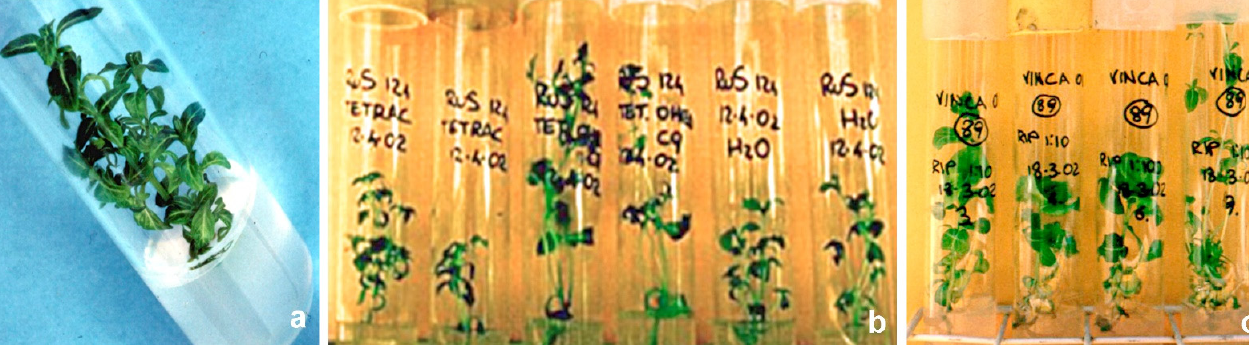
Figure 3. Periwinkle shoots in micropropagation: ( a ) untreated shoot; ( b ) phytoplasma-infected shoots treated with tetracyclines (the two central shoots were treated with 9 CH dynamized tetracycline); ( c ) shoots treated with PAPII.